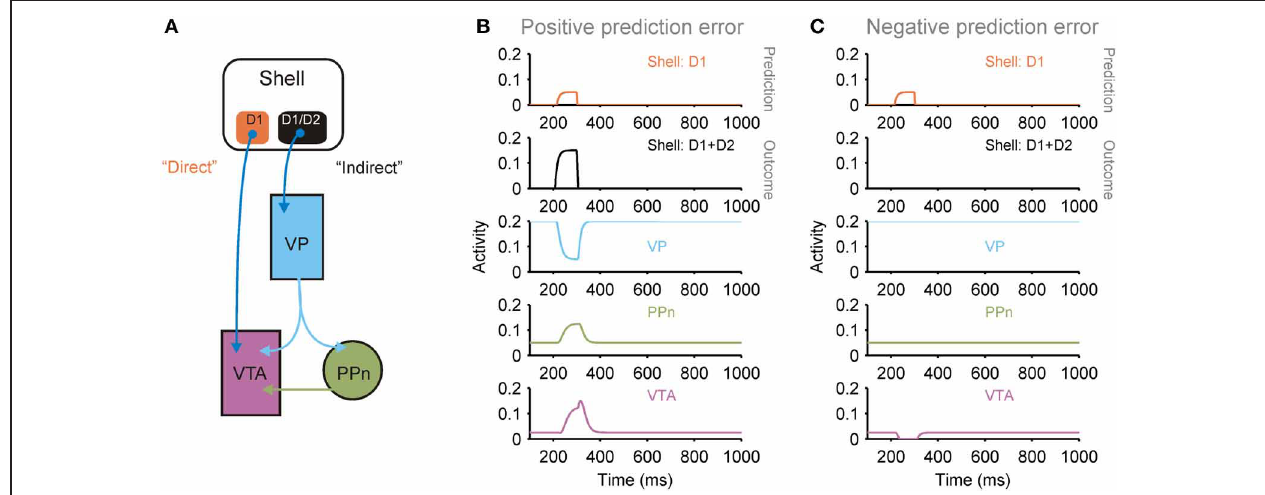
FIGURE 5 | Dual pathways from shell to ventral tegmental area (VTA) potentially support prediction error computation. (A) The medial and lateral shell both support a dual pathway circuit that converges on dopaminergic neurons in the VTA: a direct pathway originating from a population of D1 receptor expressing striatal projection neurons, and an indirect pathway originating from a mixed population of D1 and D2 receptor expressing striatal projection neurons [see (Humphries and Prescott, 2010) for review]. This arrangement is consistent with the shell’s role as a “critic”: the pathways support the computation of a prediction error between the